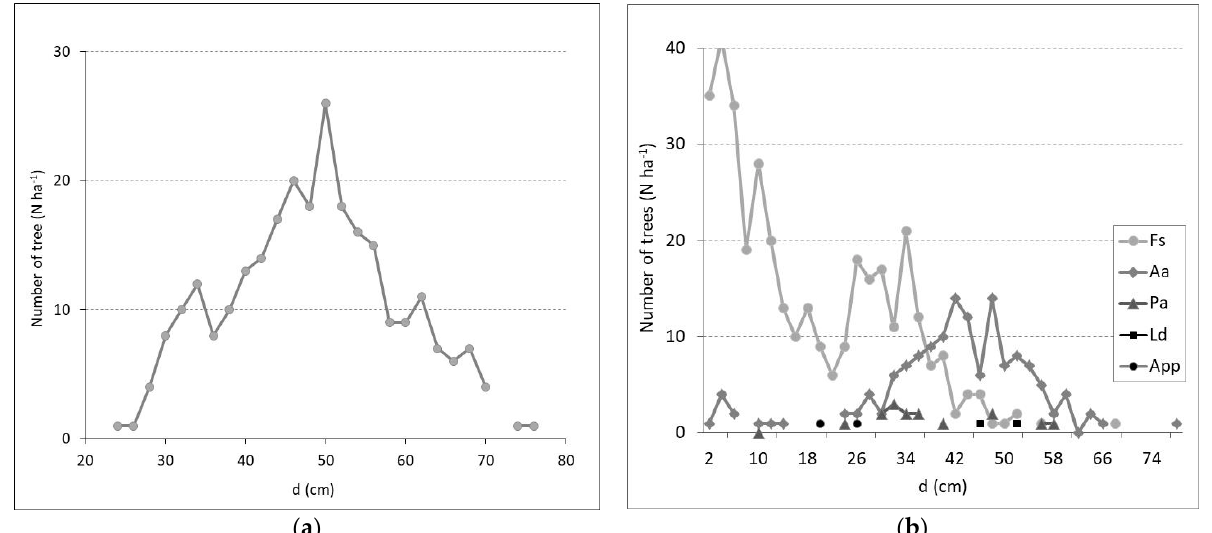
Figure 4. Number of trees vs. diameter distribution in ( a ) a beech stand (aged 140 years) and ( b ) a mixed beech − fir stand (aged 120 years ). Fs − Fagus sylvatica L.; Aa − Abies alba Mill.; Pa − Picea abies Karst.; Ld − Larix decidua Mill.; App − Acer pseudoplatanus L. The beech stand had a greater variation in